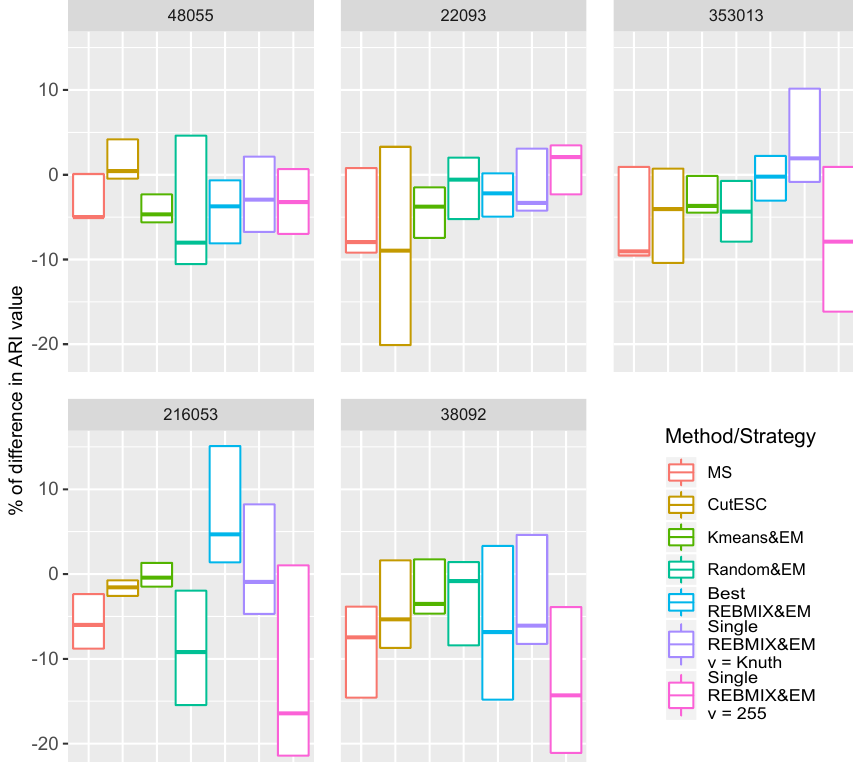
Figure 12. Difference in ARI value between noisy and non-noisy images for each